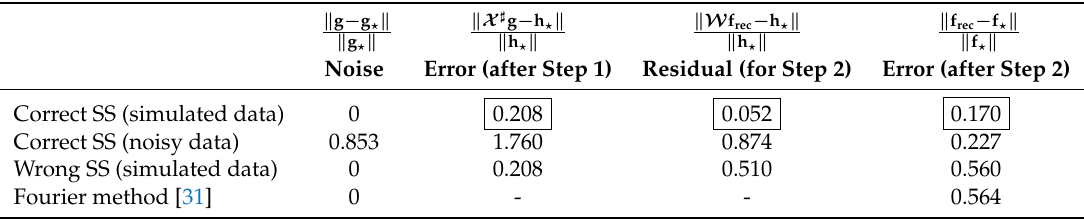
Table 1. R ELATIVE ERROR METRICS FOR THE FFD DATA AND RECONSTRUCTIONS . The first column shows the relative (cid:96) 2 -norm of the noise added to the data. The second column shows the relative (cid:96) 2 -reconstruction error after step one (not applicable to Fourier reconstruction). The third column shows the relative residual error which are minimized in step 2 of the iterative algorithms. The last column shows the relative (cid:96) 2 -error of final